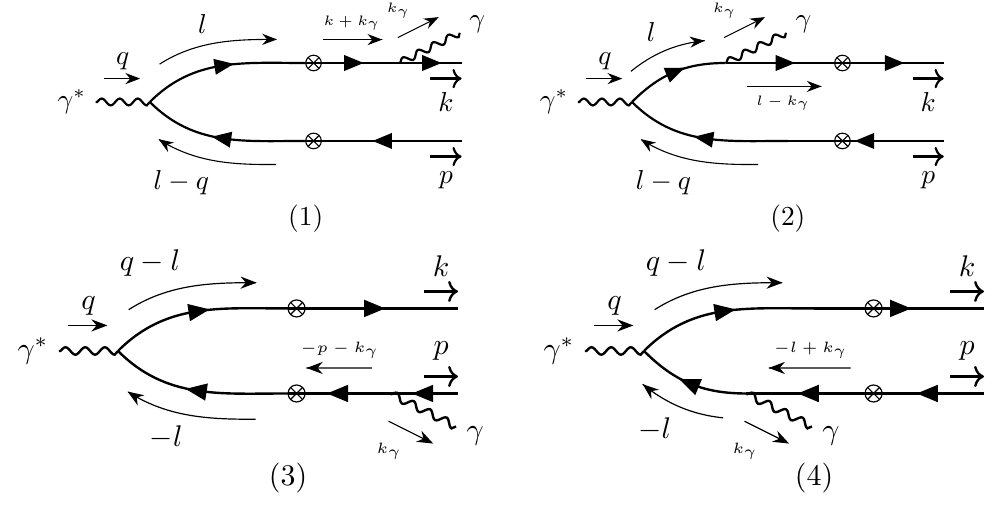
Figure 1 . Diagrams contributing to the LO amplitude of γ + q ¯ q production at small x in the CGC EFT. Top (bottom) diagrams correspond to the photon emission from the quark (antiquark). We explicitly show the choice of internal momenta. The crossed circles represent the effective vertices that contain all possible eikonal interactions with the background classical field of the nucleus. We must subtract the “no-scattering” contribution from the amplitudes of each of these graphs to obtain the physical